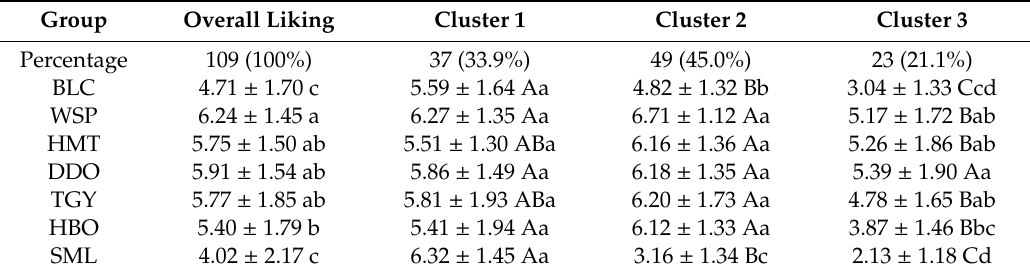
Table 4. The three types of tea consumers clustered by hierarchical clustering analysis of the overall liking mean values. Group Overall Liking Cluster 1 Cluster 2 Cluster 3